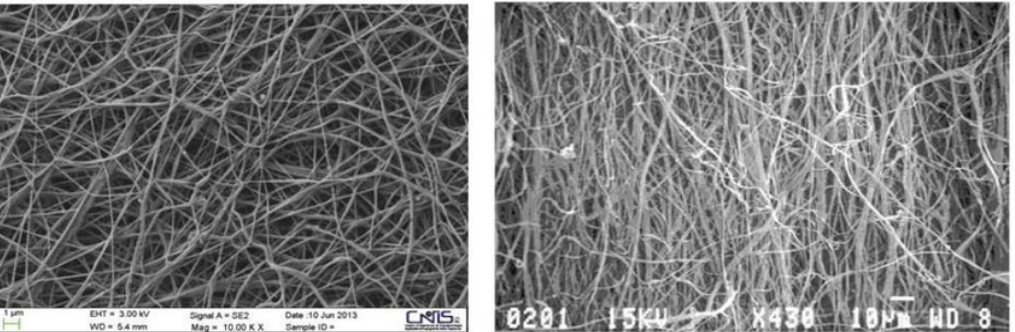
Figure 7. Structure of chitin-made tissue (left) compared to the Natural ExtracellulaMatrix (ECM (right). By Scanning Electron Microscopy (SEM) (Reprinted with permission from Donnarumma et al. (2019). 2019. MDPI [89]).